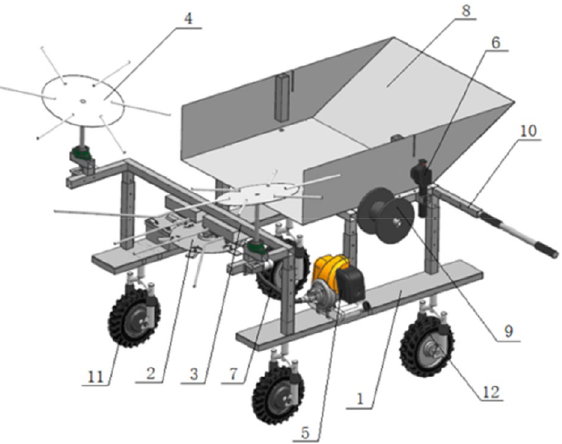
Figure 1. Schematic diagram of edible rose pruning machine. Note: 1, frame; 2, single disc cutter; 3, cutter support frame; 4, closing branches dish; 5, gasoline engine; 6, throttle controller; 7, flexible shaft; 8, collection box; 9, wire reel; 10, push rod; 11, directional wheel; 12, universal